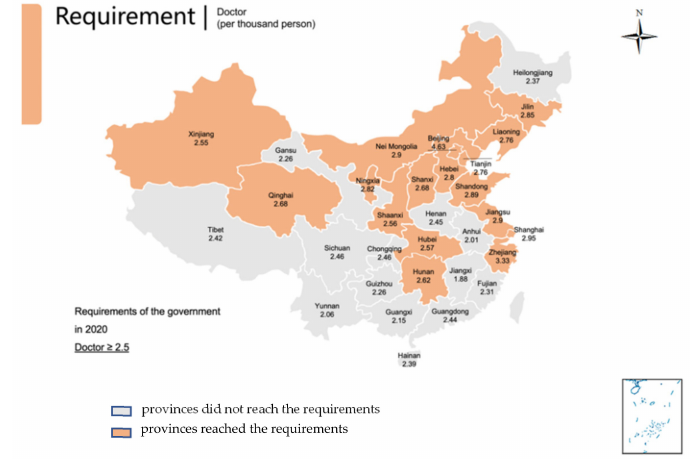
Figure 6. Provinces reached the requirements of the number of doctors in 2020 by the government; Provinces did not reach that requirement.